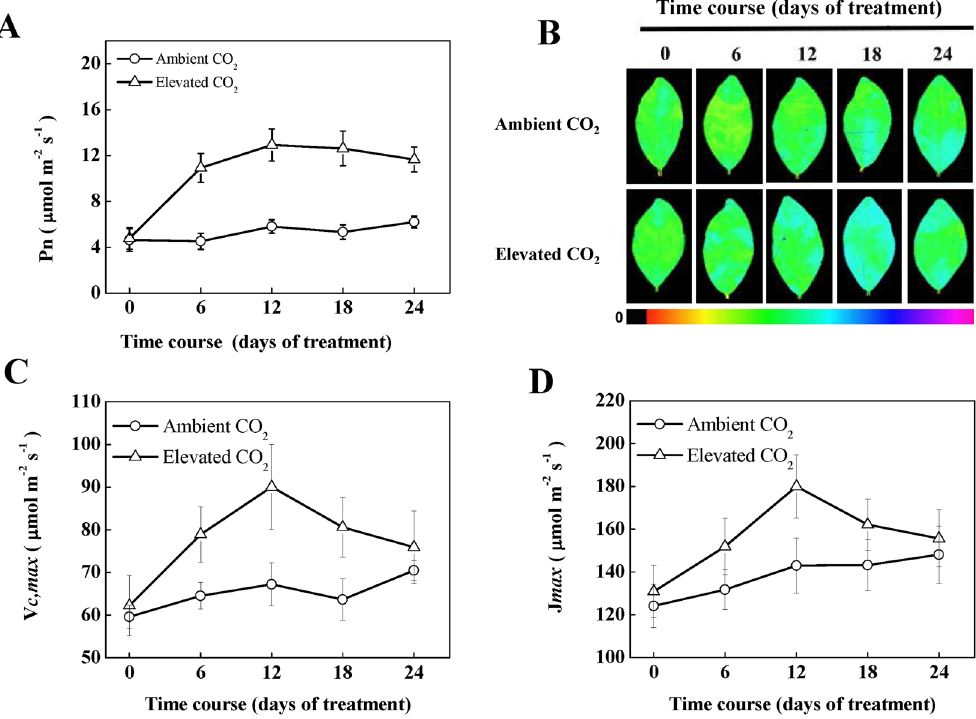
Figure 1. Photosynthetic response of tea plants to elevated CO 2 . ( A ) Net photosynthetic rate (Pn), ( B ) the quantum efficiency of photosystem II ( Φ PSII ), false colour code depicted in the image ranges from 0 (black) to 1(purple), ( C ) maximum carboxylation rate of RuBisCO ( V cmax ), ( D ) maximum rates of RuBP regeneration ( J max ). Tea seedlings were exposed to either ambient (380 µ mol mol − 1 ) or elevated CO 2 concentration (800 µ mol mol − 1 ) for 24 days. Measurements were taken at different time-points as mentioned in the respective figures. The results are expressed as the mean values ± SD, n =